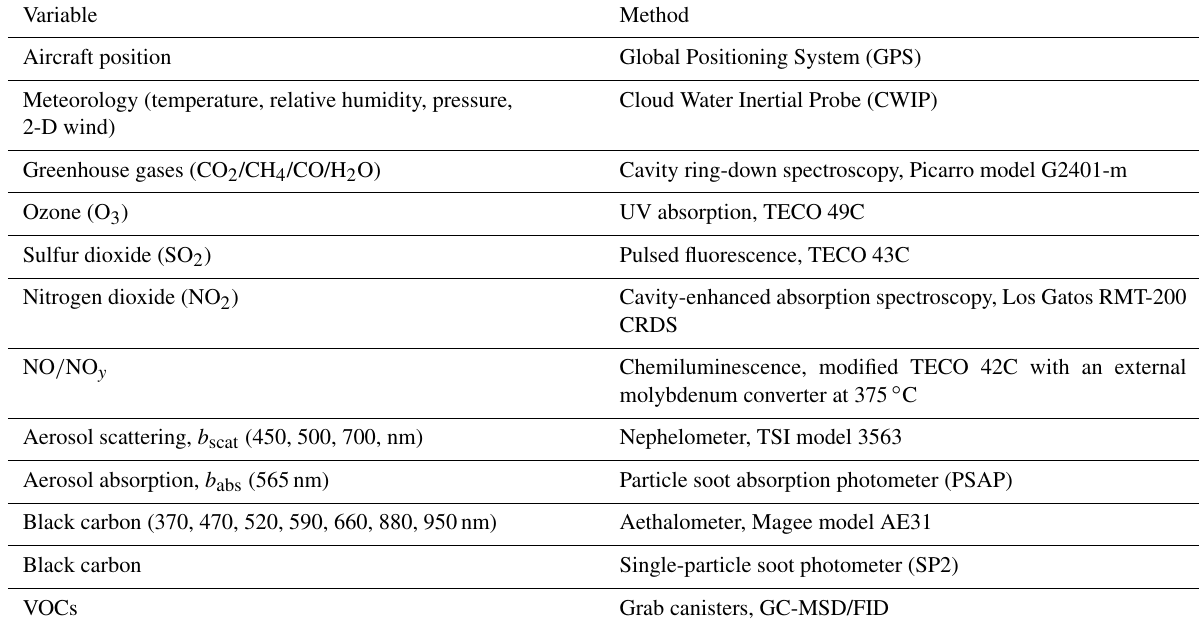
Table 1. Y-12 research aircraft instrumentation during ARIAs. Variable Method Aircraft position Global Positioning System